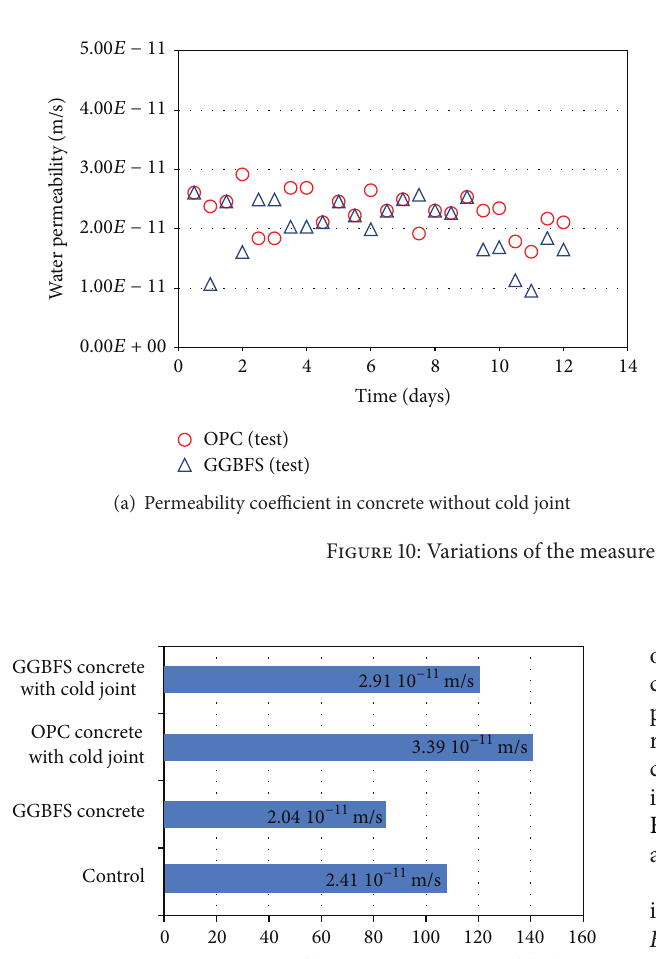
Figure 9: Ratios of water drainage to control case (after 2 weeks).